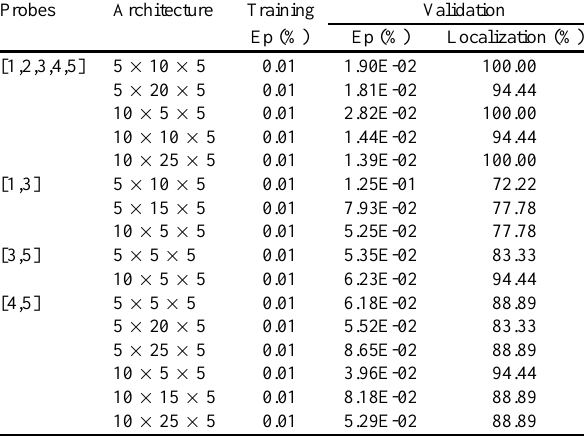
Table 4 Training and validation results for the unbalance identification